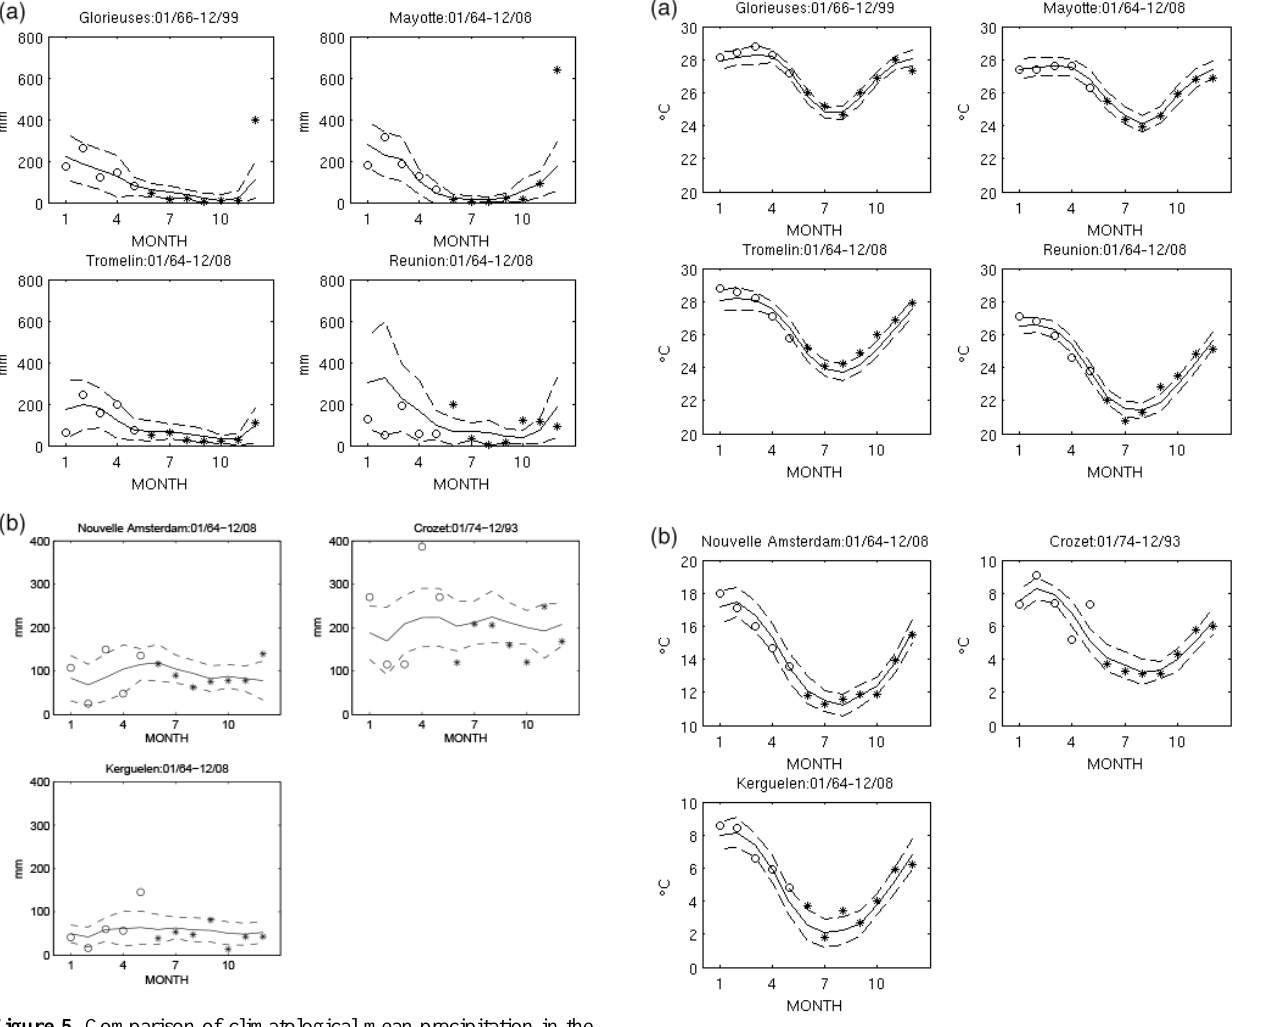
Figure 6. Same as Fig. 5 but for